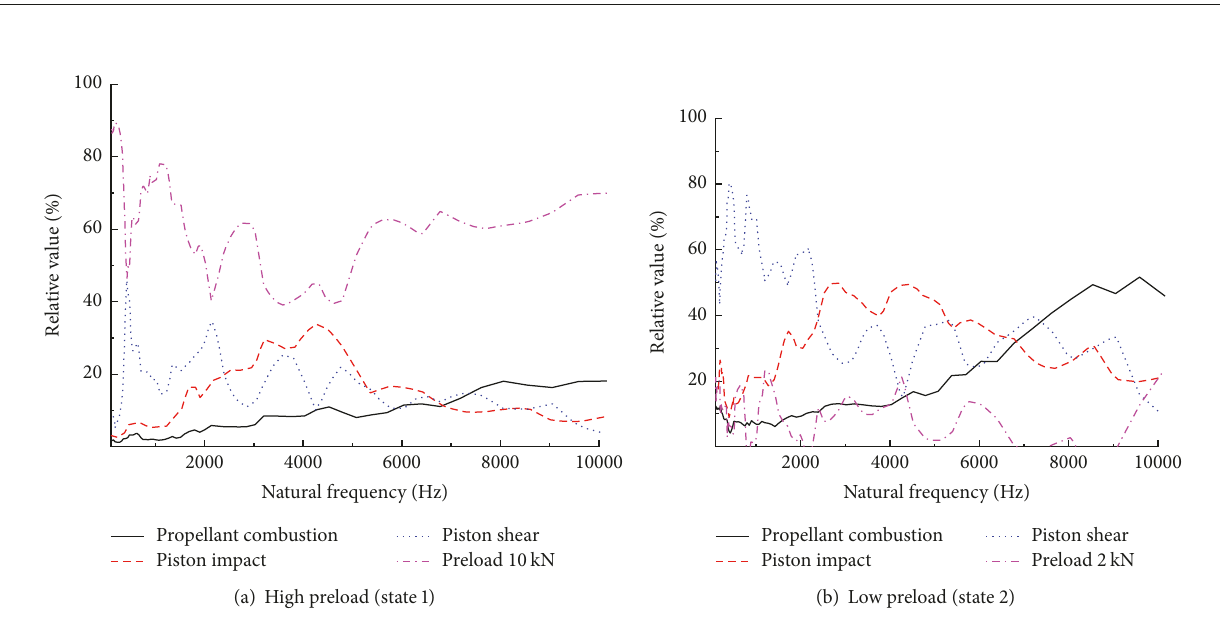
Figure 11: Relative value of output